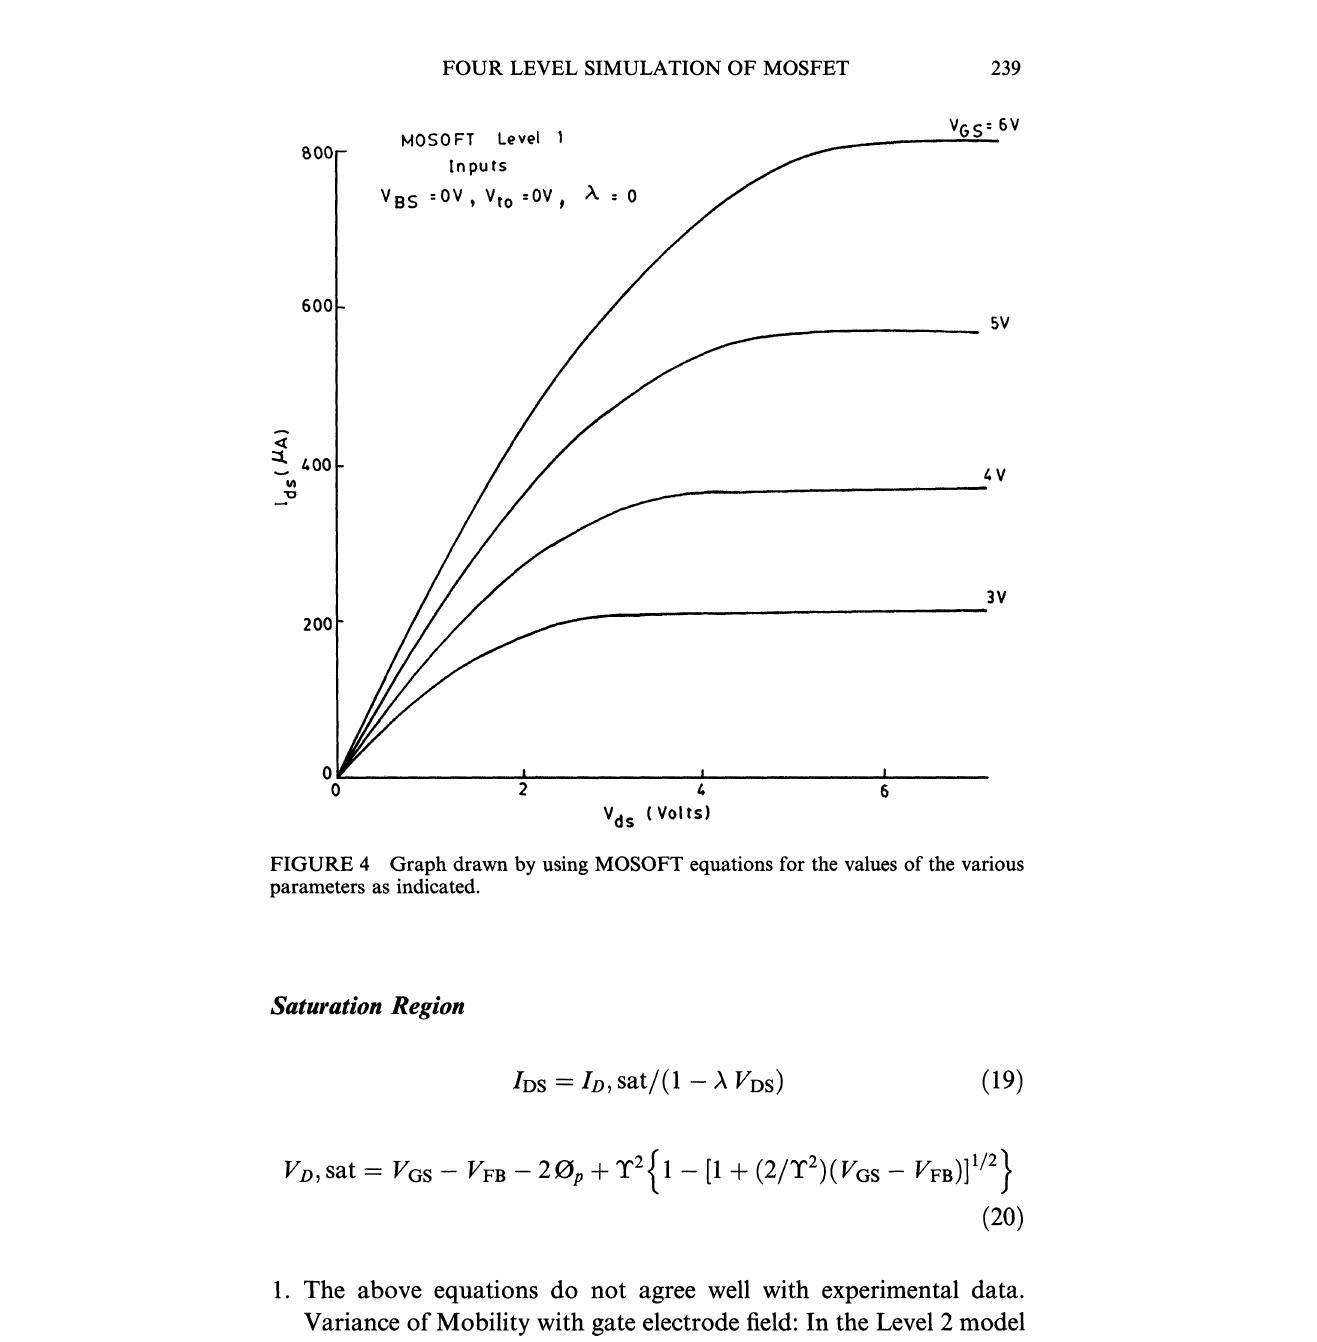
FIGURE 4 Graph drawn by using MOSOFT equations for the values of the various parameters as